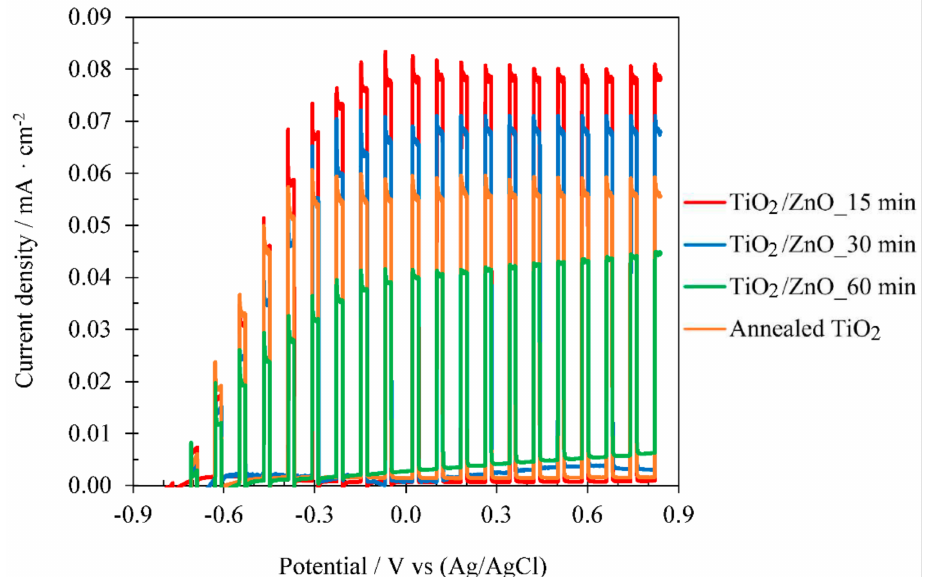
Figure 3. Effect of the electrodeposition time on the photoelectrochemical water splitting tests under dark and illuminated conditions (AM 1.5) for TiO 2 /ZnO hybrid nanosponges electrodeposited at 25 ◦ C with 1 mM Zn(NO 3 ) 2 on crystalline TiO 2 (comparison with TiO 2 nanosponges). The photocurrent density at 0.6 V Ag/AgCl of the TiO 2 /ZnO hybrid nanosponges elec- trodeposited for 15 min increased by 37.5% compared to the TiO 2 nanosponges. Comparing the results obtained in the photoelectrochemical water splitting tests using TiO 2 /ZnO hy- brid nanosponges electrodeposited on crystalline TiO 2 at 25 ◦ C with 1 mM Zn(NO 3 ) 2 for 15 min (i max = 0.077 mA · cm − 2 ) with the best results obtained in the previous research [33] using TiO 2 /ZnO hybrid nanotubes electrodeposited on amorphous TiO 2 at 25 ◦ C with 1 mM Zn(NO 3 ) 2 for 60 min (i max = 0.036 mA · cm − 2 ), the photoelectrochemical performance